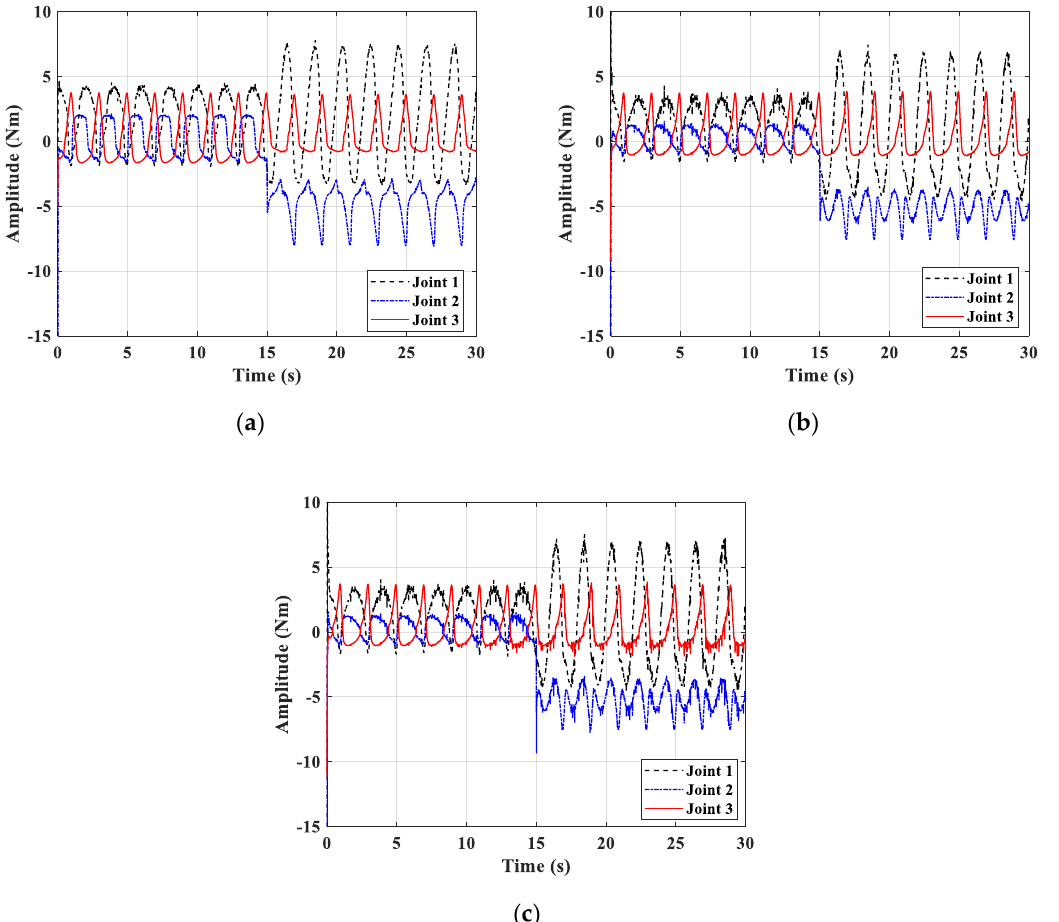
Figure 13. Control signals of the proposed control at 0.5 Hz: ( a ) backstepping control; ( b ) LESOBC; and ( c ) proposed control.